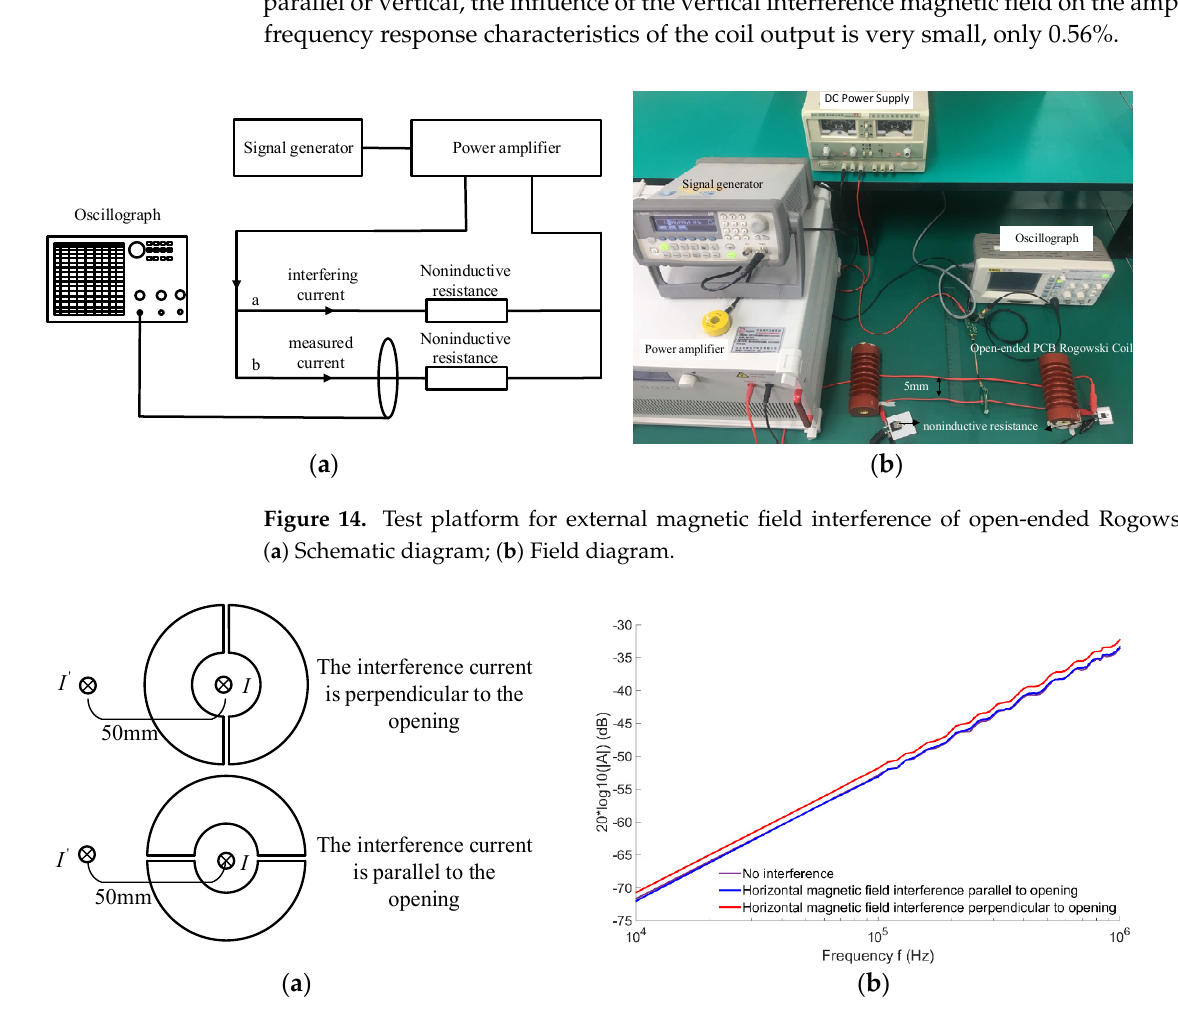
Figure 15. Horizontal magnetic field interference. ( a ) Placement method; ( b )The amplitude-frequency response curve of Rogowski coil with external parallel interference.